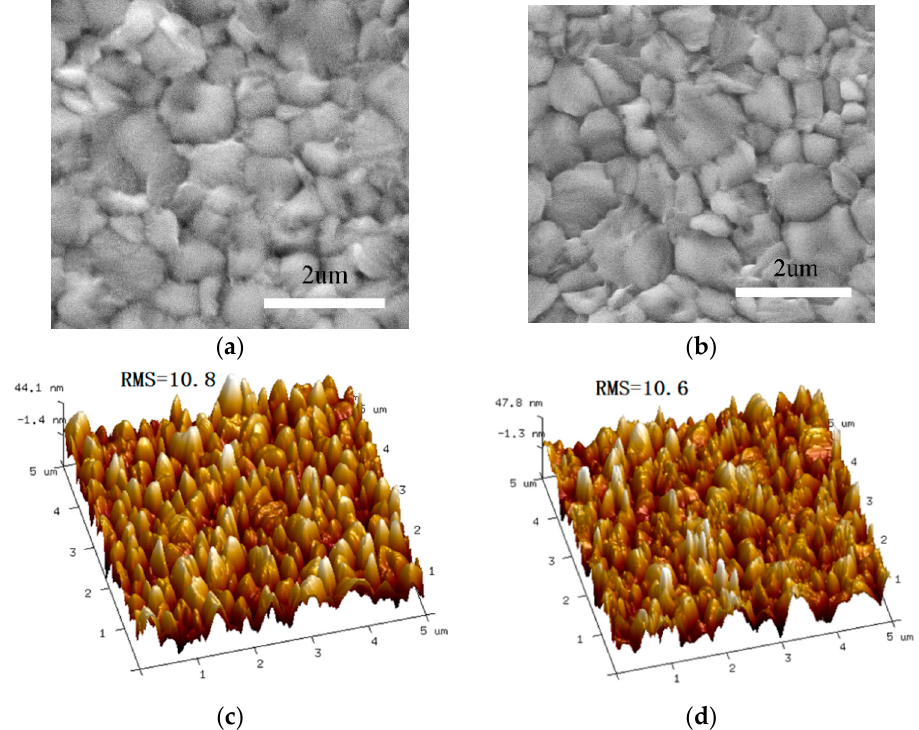
Figure 4. SEM and AFM images of perovskite film based on ( a , c ) Ni/Au mesh and ( b , d ) ITO electrodes. The unit of RMS values are nm.